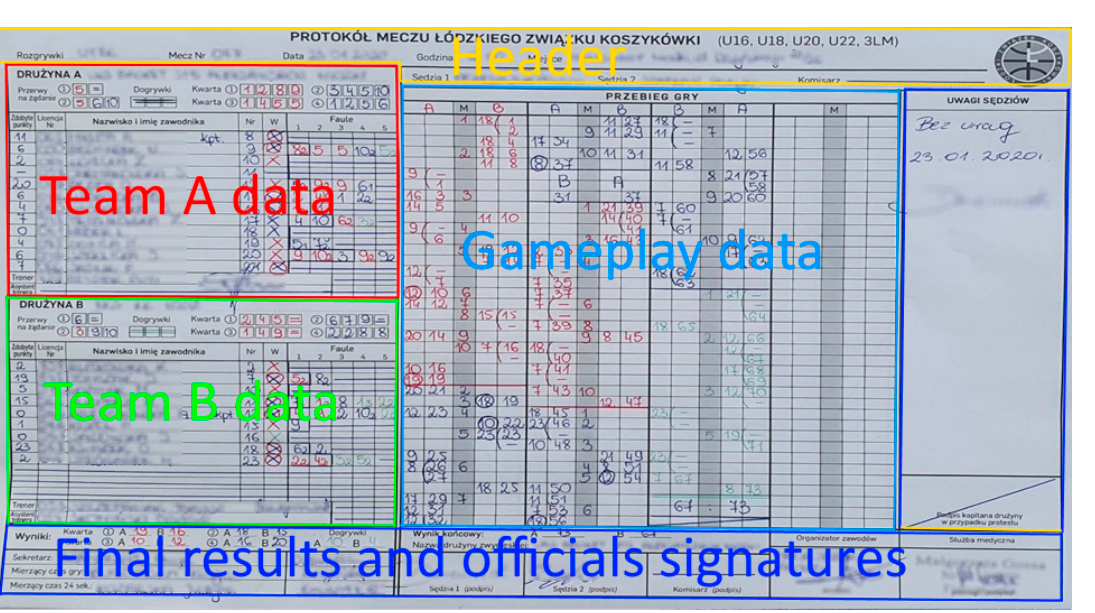
Figure A1. Structure of match protocol. At the top of the protocol, we have match data: date, hour and place, and league and match number. On the left side, we put information about the teams. Team A attacks the left side of the court at the beginning of the match. Each player in the team has a unique number. An example of the entry is shown in Table A1. Table A1. Player details in match protocol. Points